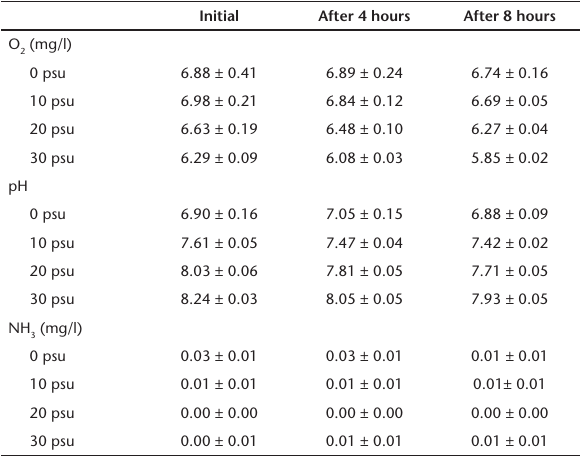
Table 1. Initial and final concentrations of oxygen and ammonia, and values of pH in the water of “blank” containers, without any shrimp, in salinities 0 (control), 10, 20, and 30 psu, for 4 and 8 hours of exposure (n = 6 for each